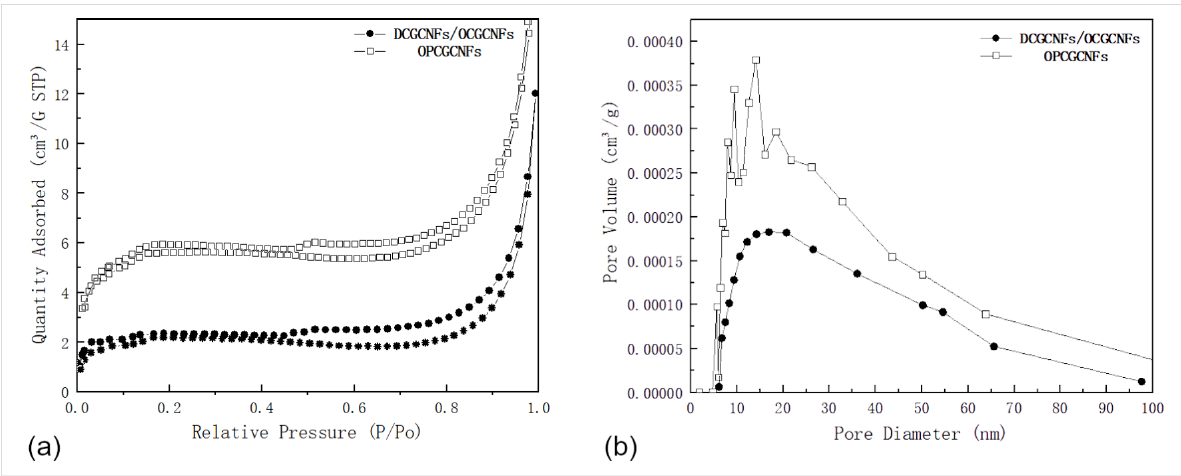
Figure 4: (a) Nitrogen adsorption–desorption isotherms and (b) their corresponding PSD curves determined by the BJH method applied to DCGCNFs/OCGCNFs and OPCGCNFs.